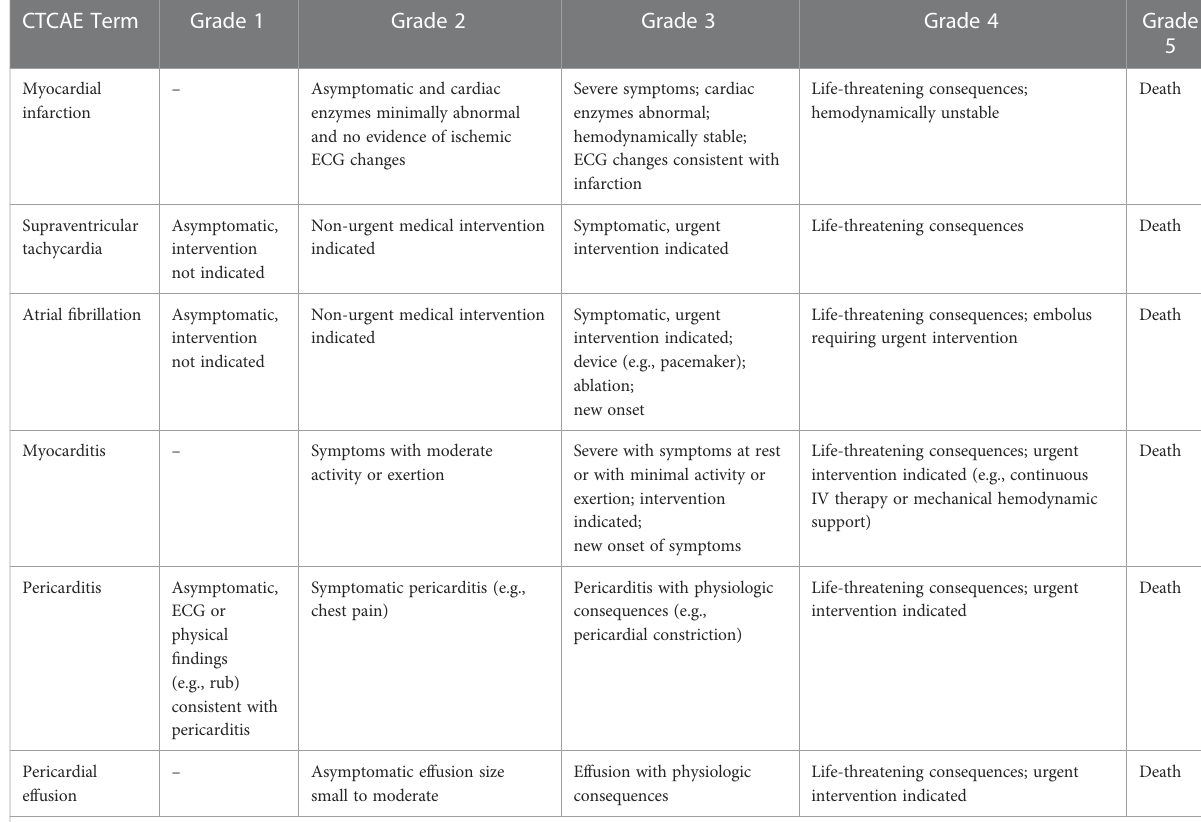
TABLE 1 CTCAE toxicity grading scale for